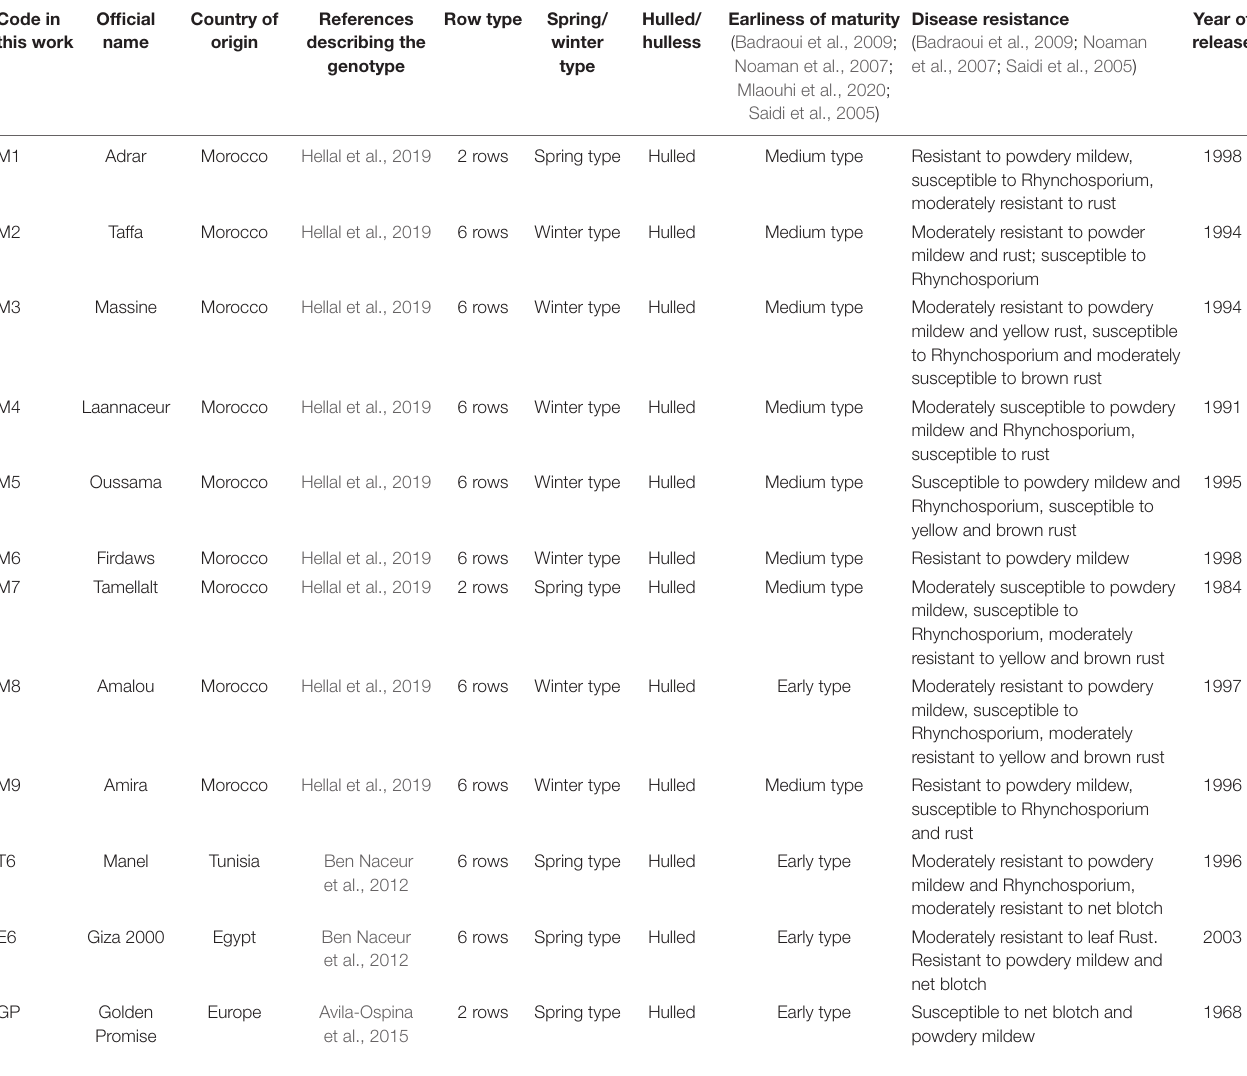
TABLE 1 | Names and characteristics of the barley collection genotypes used in this